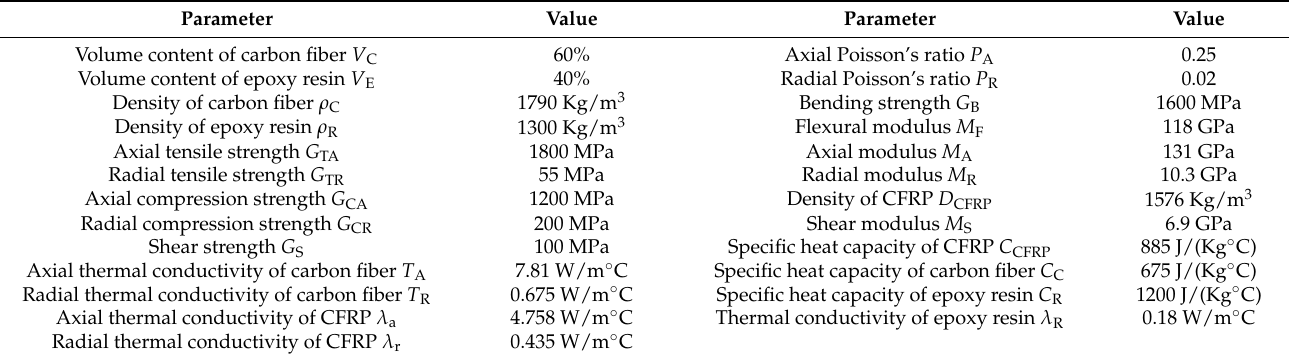
Table 2. Basic performance index of T300 CFRP.